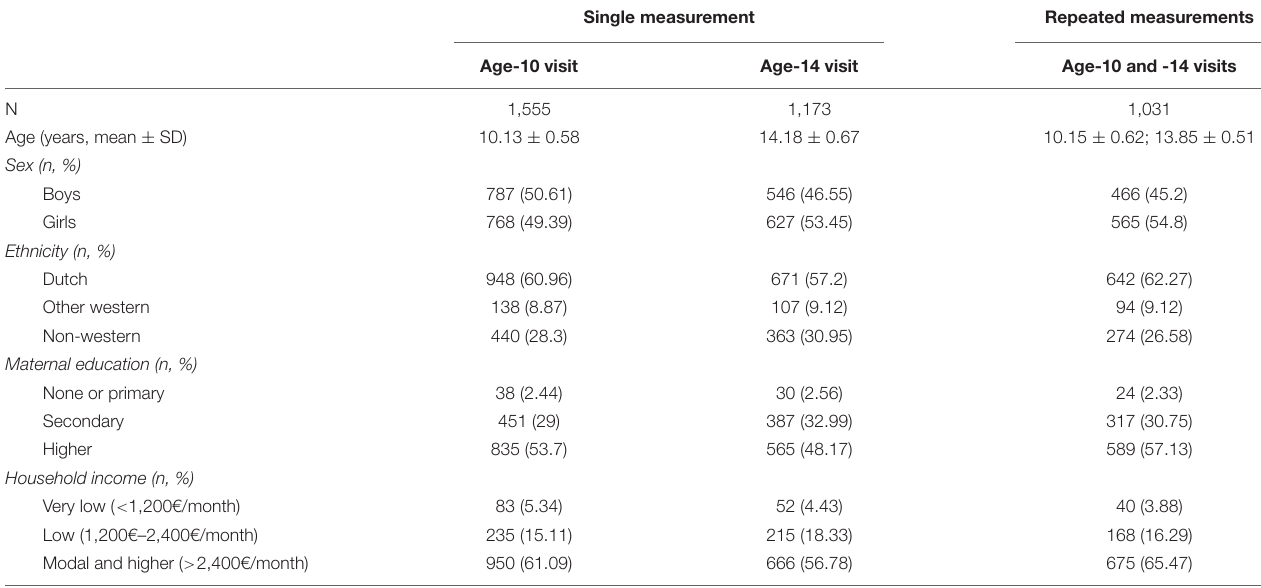
TABLE 1 | Sample characteristics.